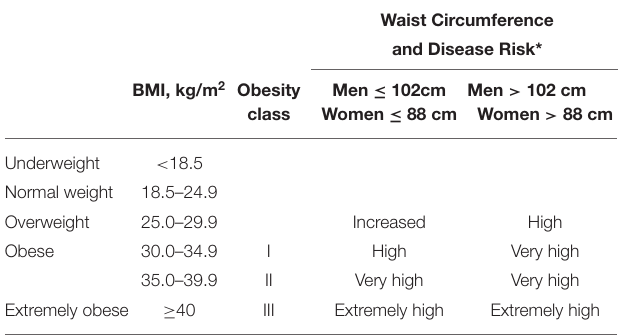
Prediabetes Diabetes